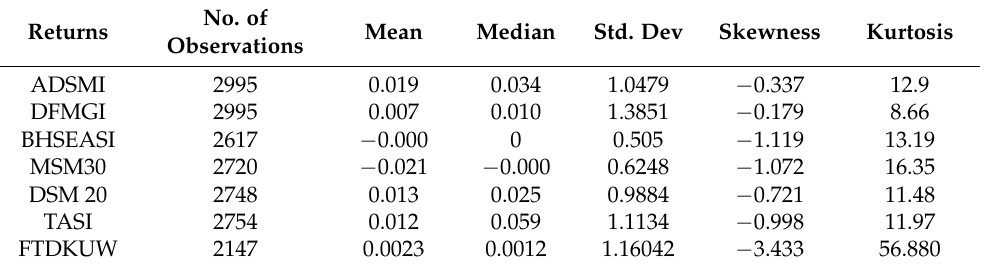
Table 2. Descriptive Statistics of the GCC Indices Returns for the period from 1 January 2010 to